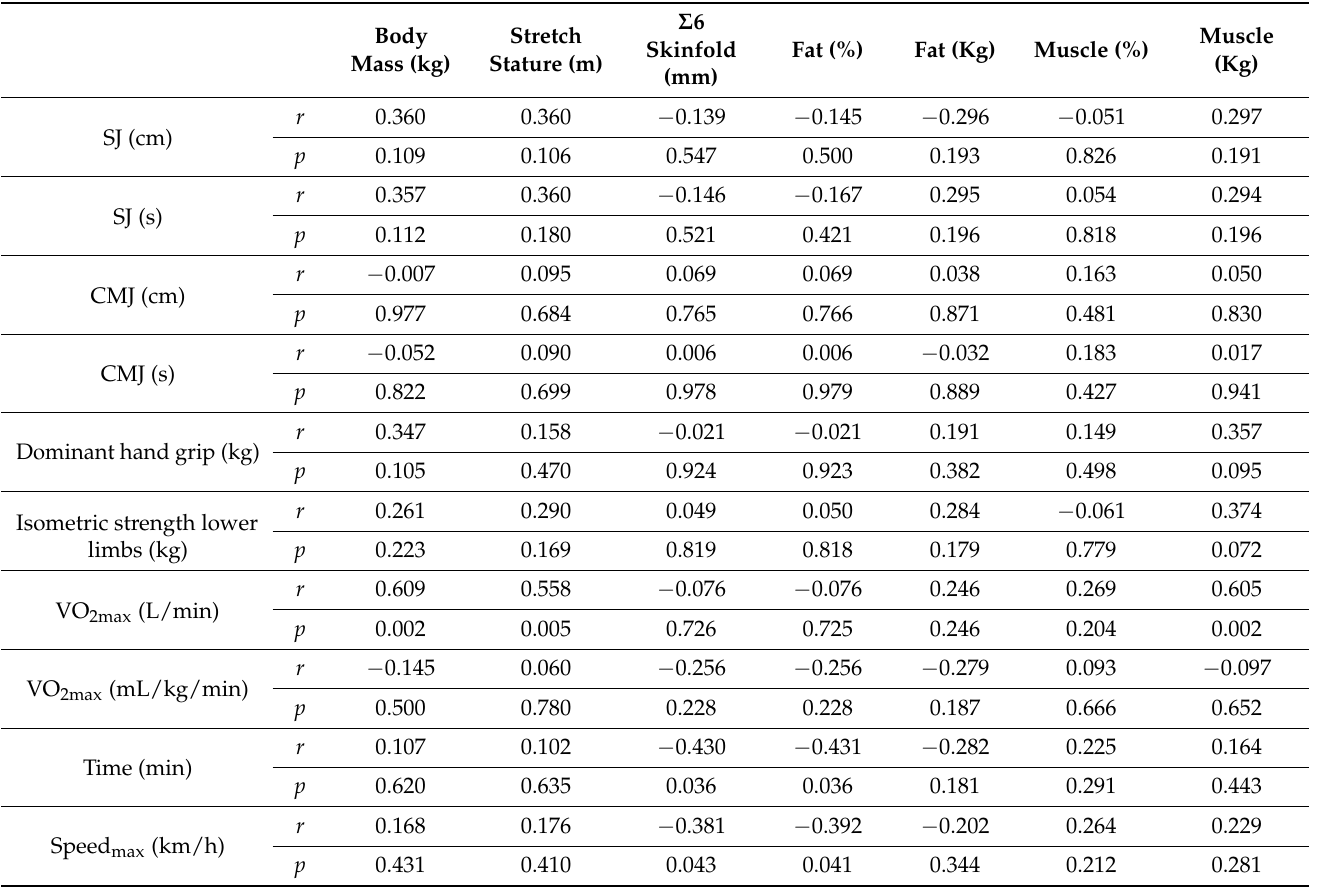
Table 5. Relationships between anthropometry and body composition parameters and physical condition parameters in men soccer players.